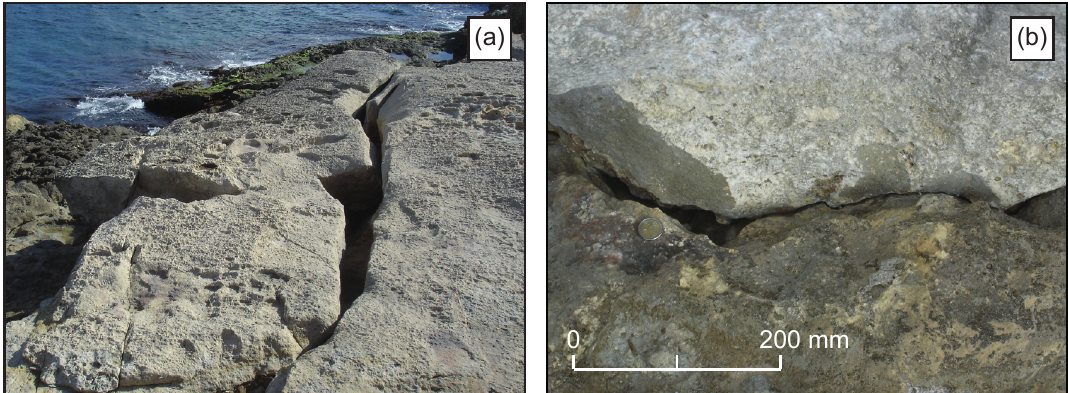
Figure 19. Newly detached rock masses trapped against their scarp of origin: ( a ) a line of three scarp foot boulders, separated from the adjacent scarp and confined in their current position until the occurrence of some major event with su ffi cient power to displace them; ( b ) contact between the base of a large detached scarp foot LGL boulder (shown in Figure 4) and the subjacent surface of the LCL shore platform. The pale, freshly fractured rock surface above is the boulder’s b-c facet and the darker colonised surface beneath is the irregular surface of the shore platform. The mutual grinding of the two surfaces has developed a perfect congruence where the two are in direct contact with each